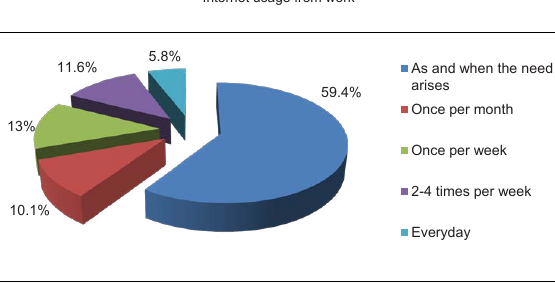
FIGURE 1 Internet usage from